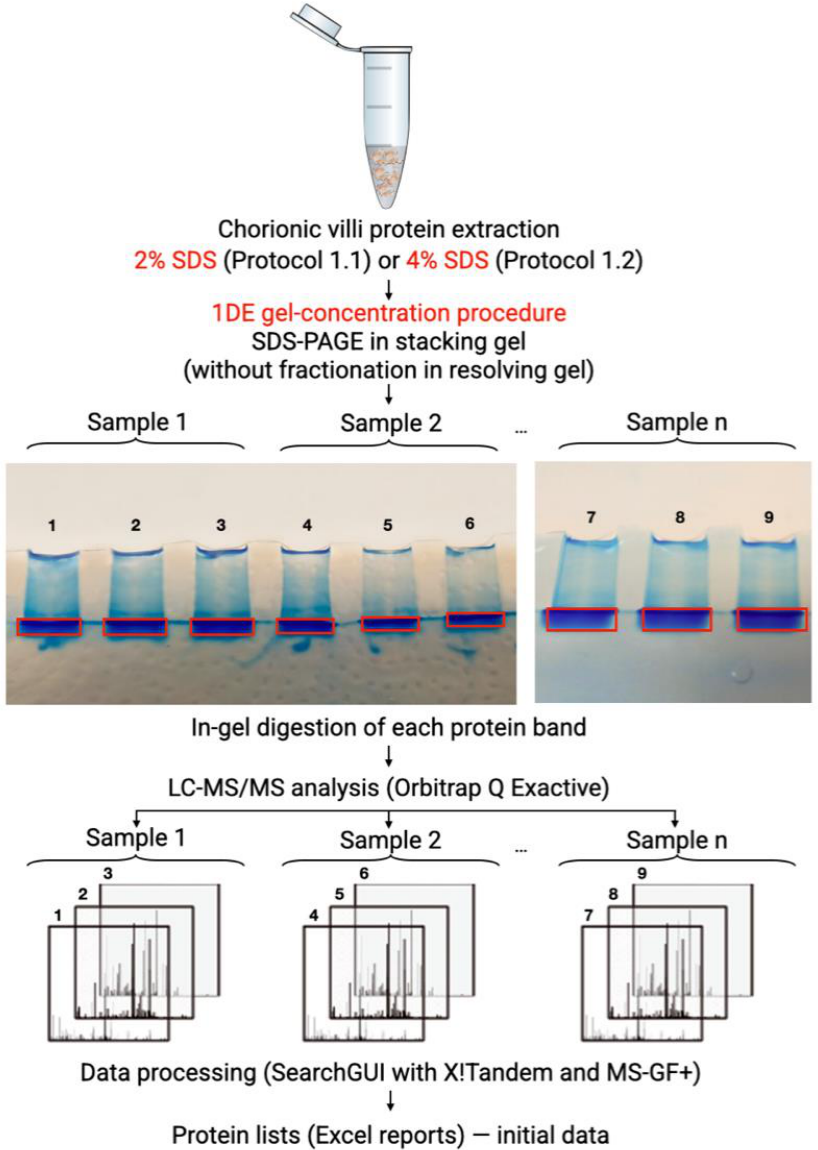
Figure 2. Scheme of the 1DE-gel concentration procedure. Human chorionic villi samples were solubilized in buffers based on 2% or 4% SDS and then sonicated. The obtained protein extracts were deposited onto polyacrylamide stacking gel (4%T) (in triplicate, 50 µ g of protein per gel run). Electrophoresis (50 V, 45 min) was terminated before the migration of Bromophenol blue in the resolving gel. The single protein bands were excised from gel holistically and digested with trypsin. The resulting mixture of peptides was extracted for LC – MS/MS analysis.